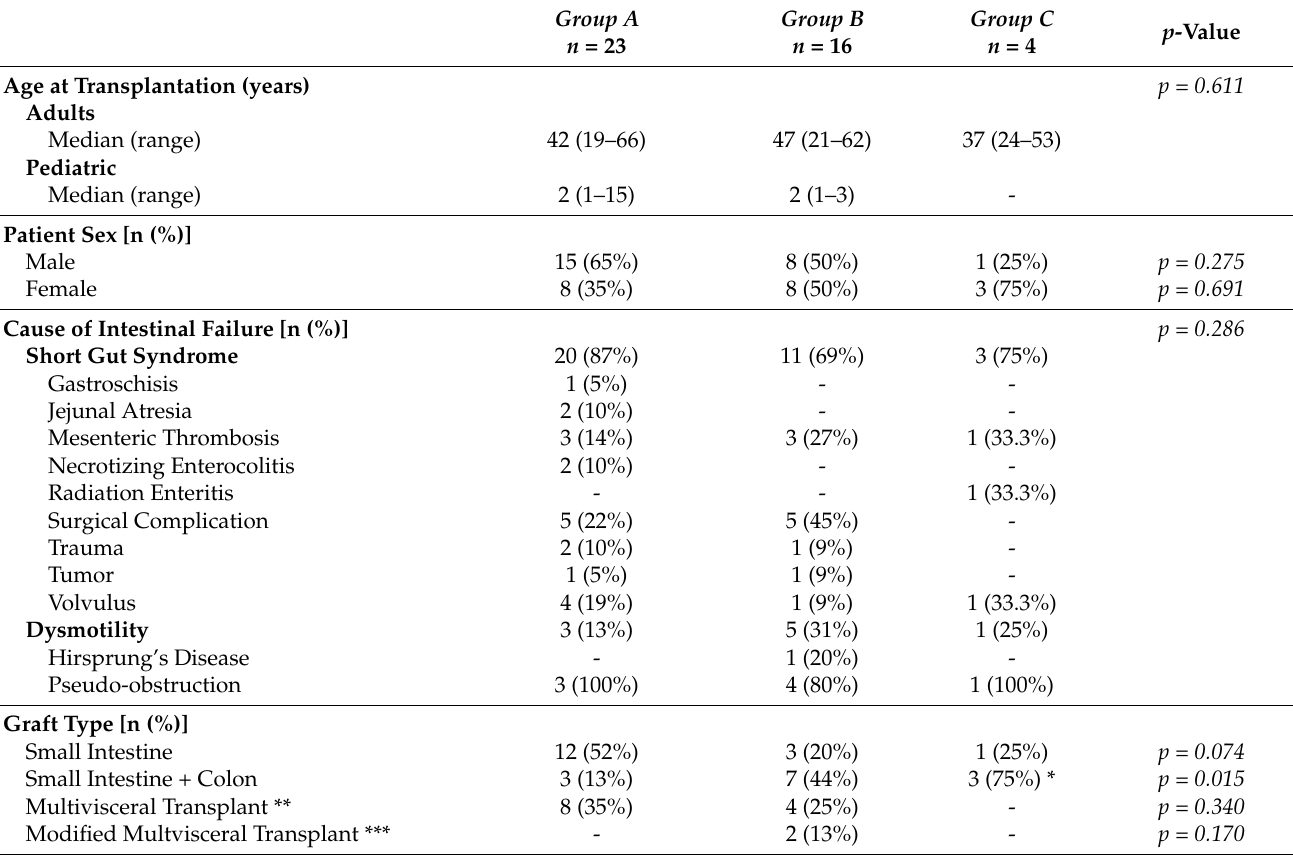
Table 1. Patient